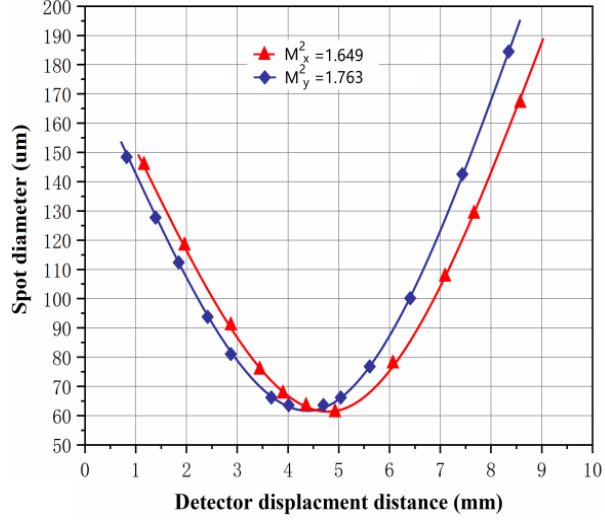
Figure 8. Beam quality factor (M 2 ) of ASE source at the output power of 1.73 kW.